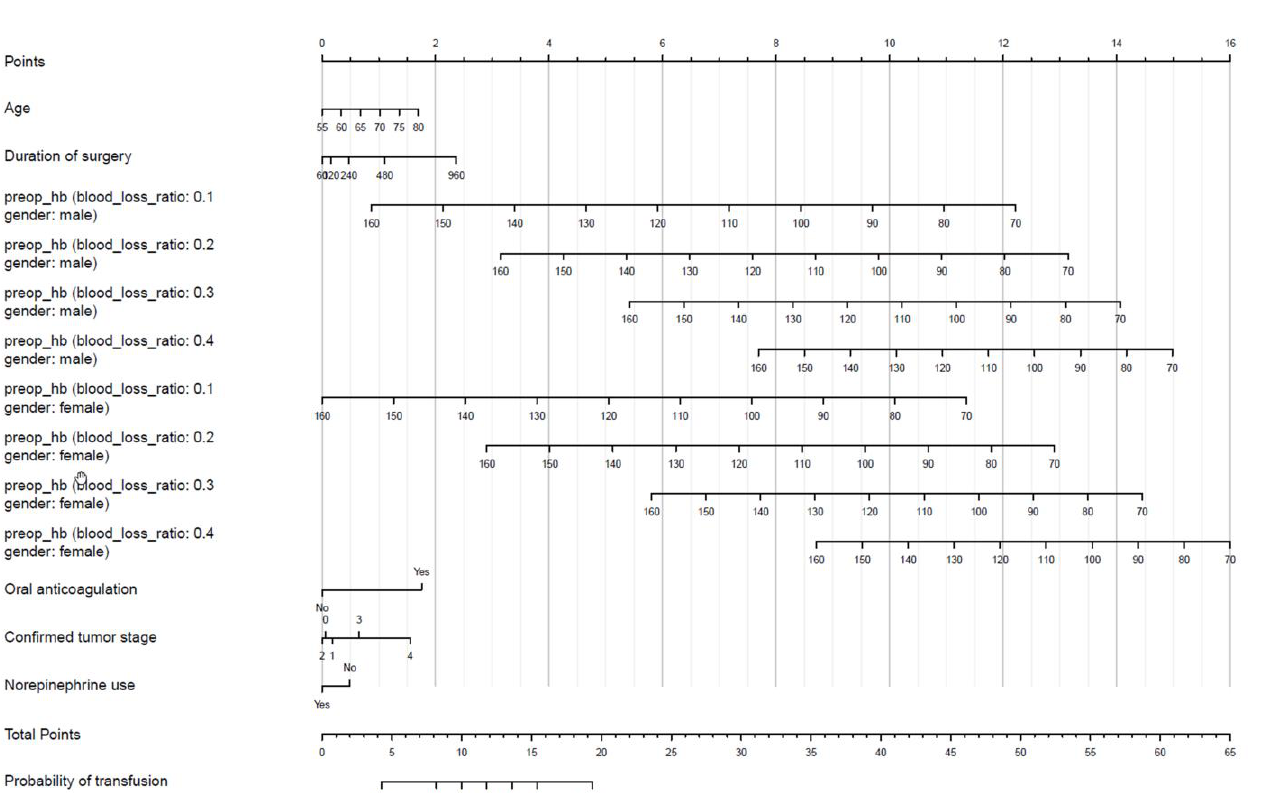
Table 3. Estimated marginal means for tumor stage (i.e., mean change contrasts for confirmed tumor stage). Variable